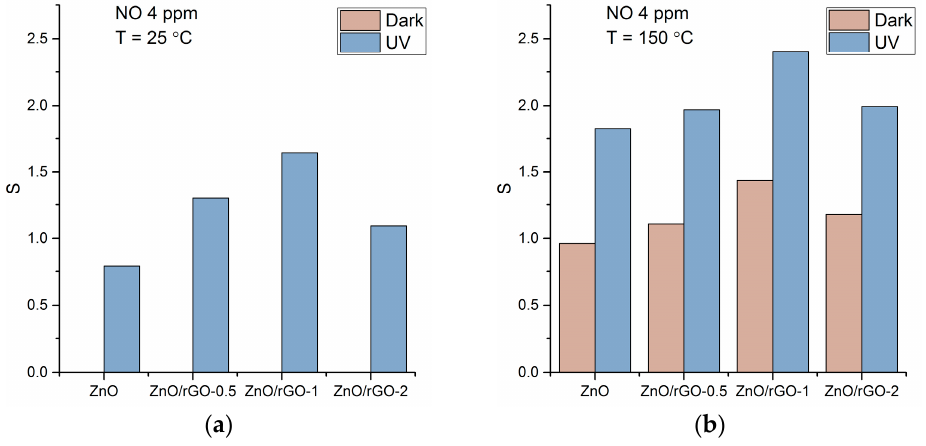
Figure 11. S ensor response of ZnO and ZnO/rGO composites when detecting 4 ppm NO in dark Figure 11. Sensor response of ZnO and ZnO/rGO composites when detecting 4 ppm NO in dark conditions and under UV illumination at 25 °C ( a ) and 150 °C ( b ). conditions and under UV illumination at 25 ◦ C ( a ) and 150 ◦ C ( b